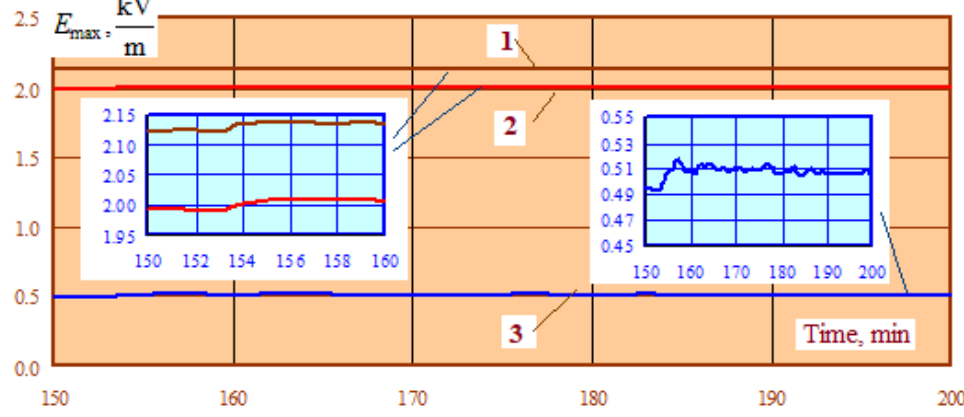
Figure 12. Electric field (EF) strength at a height of 1.8 m at the beginning of the transmission line 5.